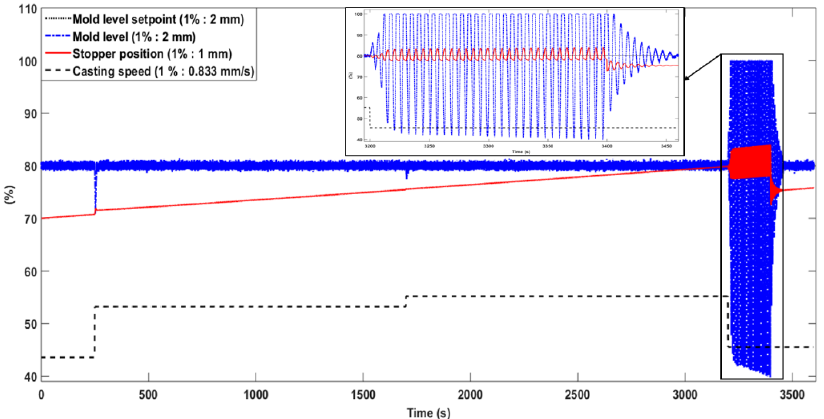
Figure 9. Simulation of conventional mold level control for a cast with SR high clogging. The operation of the MLC for steel cast number twenty with medium valve erosion was simulated for a time t = 3600 s, shown in Figure 4. At times t = 250, 1700, 3200 s strong disturbances of casting speed increasing 8, 1.66 and decreasing 8 mm/s, were introduced, respectively. The mold level performance with neuro-fuzzy adaptive MLC and not adaptive MLC, are shown in Figures 10 and 11.